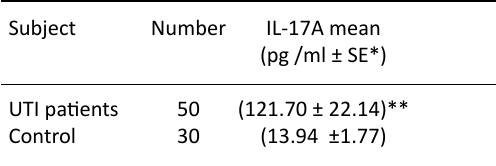
Table 2. The distribution of uropathogenic E. coli